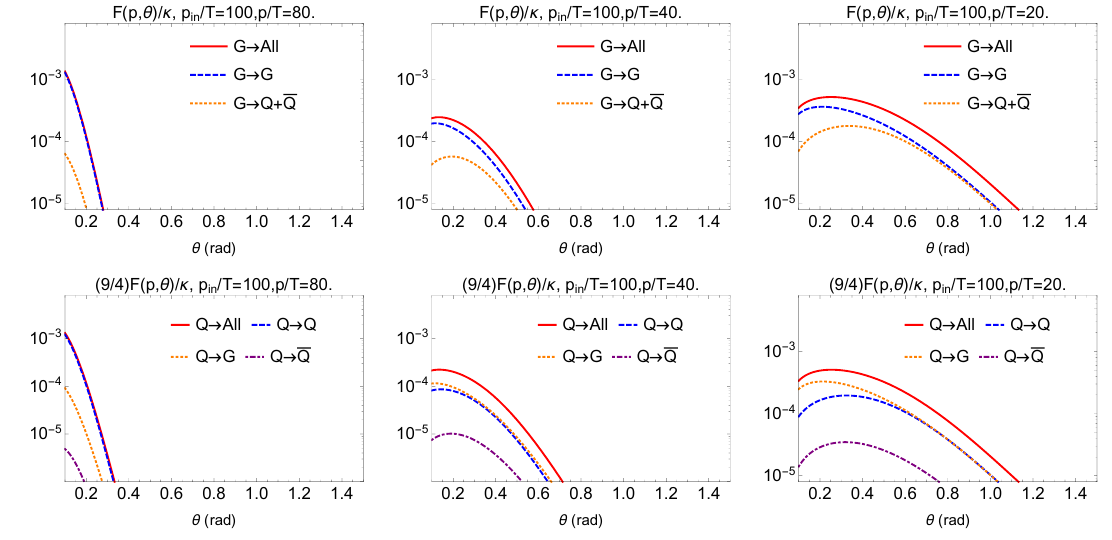
Figure 3 . The probability distributions F C ! all ( p; (cid:18) ) divided by (cid:20) = g 4 T (cid:1) t plotted as functions of (cid:18) for an incident gluon with p in =T = 100 ( C = G , upper row) and for an incident quark with p in =T = 100 ( C = Q , lower row). From left to right, the columns correspond to choosing p=T = 80, 40 and